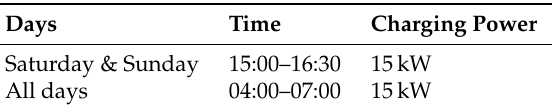
Figure 7. Time of the day with less than 20kVA power flow into the feeder. Table 4. Times of battery